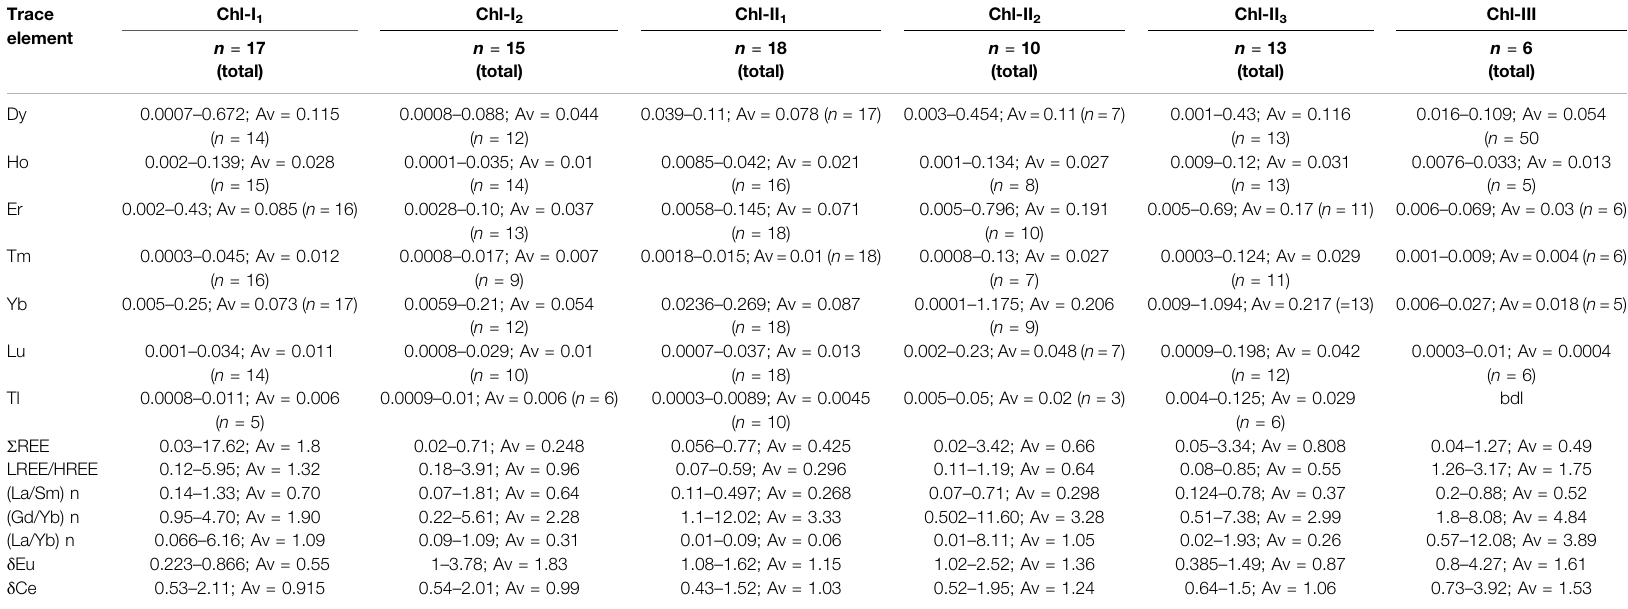
TABLE 2 | ( Continued ) In situ trace element composition and characteristic REE values of chlorite for different metallogenic stages of the Tuwu porphyry Cu deposit in eastern Tianshan, Xinjiang, NW China